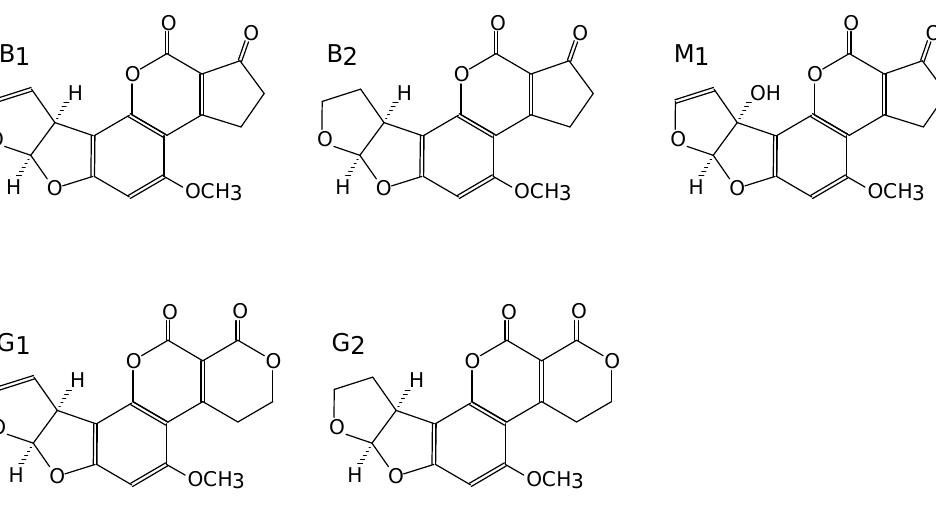
Figure 1. Structures of aflatoxins {AFs} B1, B2, M1, G1, G2.